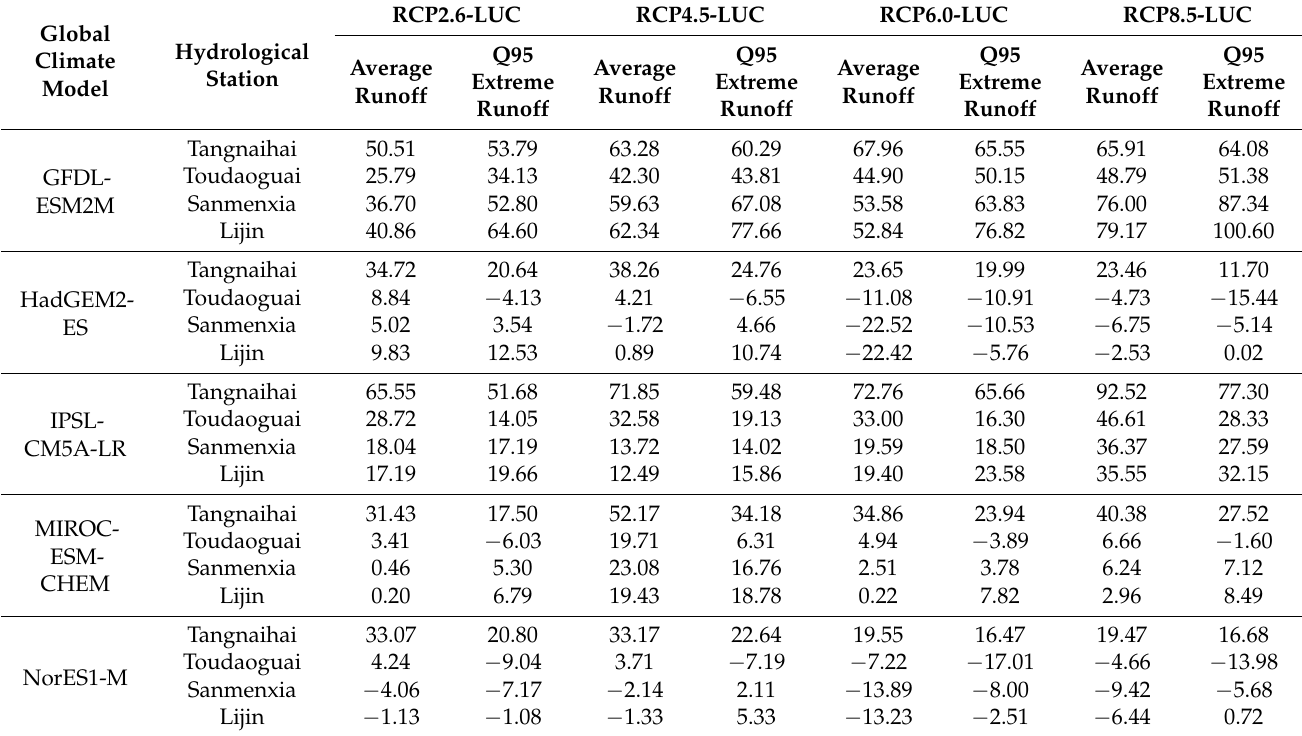
Table 9. The differences between future average runoff, Q95 extreme runoff and base period of the four hydrological stations (%). Global